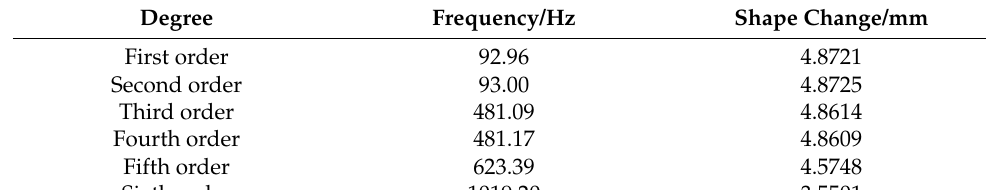
Table 2. The first six natural frequencies of the downhole solid–liquid separator.